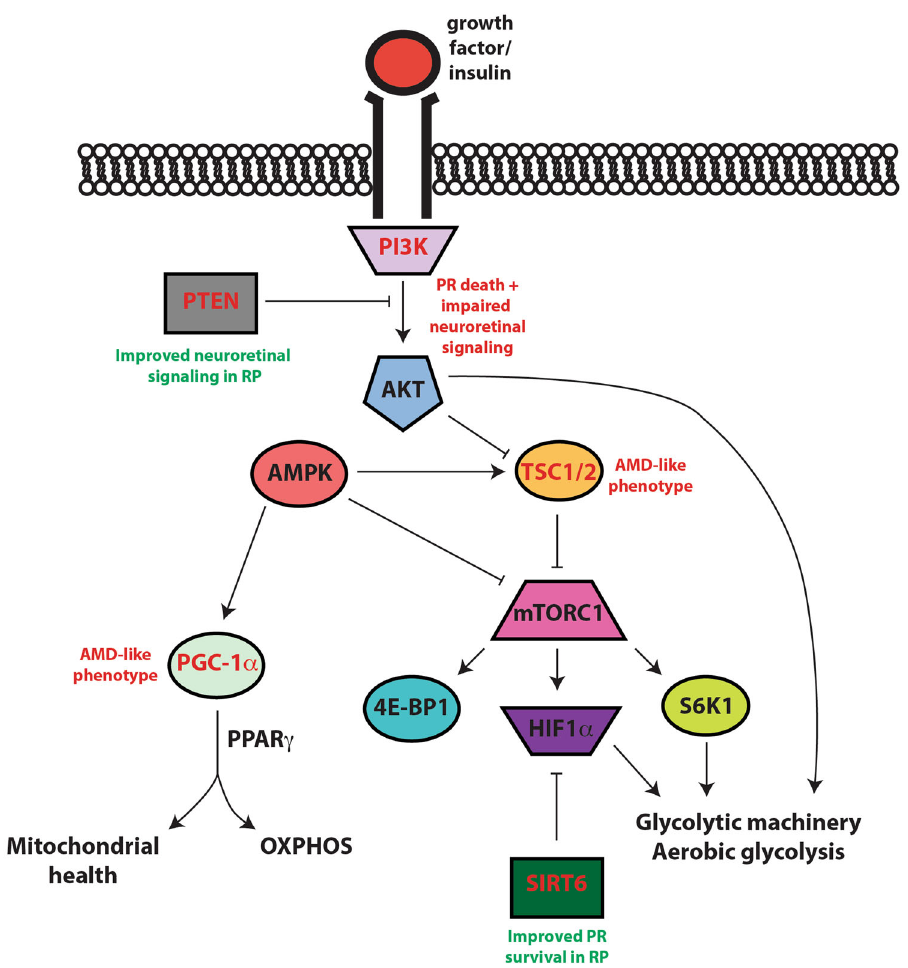
Fig. 4 mTOR pathway in photoreceptors. This cartoon summarizes the proteins in the mTOR pathway that have been shown to be important in photoreceptor survival. Upon growth factor or insulin binding, PI3K (phosphosinositide 3-kinase) promotes AKT activation, which by inhibiting the inhibitor TSC1/2 (tuberous sclerosis complex protein 1/2) complex, activates mTORC1 (mammalian target of rapamycin complex 1) and stimulates eukaryotic translation initiation factor 4E-binding protein 1 (4E-BP1), ribosomal protein S6 kinase beta-1 (S6K1), and hypoxia-inducible factor 1 alpha (HIF-1 α ). S6K1 and HIF-1 α increase glycolytic machinery and aerobic glycolysis 17,45 . Sirtuin 6 (SIRT6) also inhibits HIF-1 α 17 . PTEN (phosphatase and tension homolog deleted on chromosome ten) inhibits PI3K-mediated activation of AKT, which also directly regulates key glycolytic machinery 82,85 or controls transcription factors that promote the expression aerobic glycolysis components 186 . The nutrient sensor adenosine monophosphate activated protein kinase (AMPK) decreases mTOR signaling by activating TSC1/2 and inhibiting mTORC1 and activates PGC-1 α (PPAR γ coactivator proliferator-activated receptor gamma coactivator 1 alpha), to promote oxidative phosphorylation (OXPHOS) and mitochondrial health in conjunction with PPAR γ . Genes mutated or deleted from PRs involved in this pathway are detailed in red (PTEN, PI3K, SIRT6, TSC1, and PGC-1 α ) with their associated retinal phenotypes nearby in red